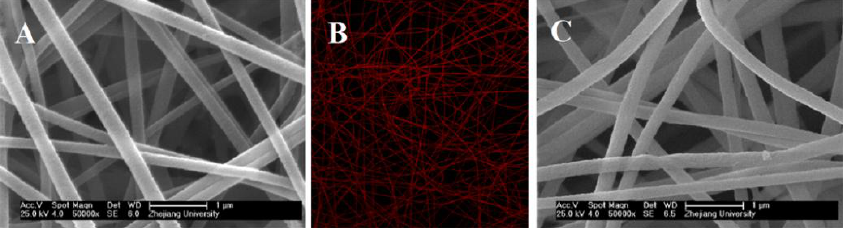
Figure 4. Absorption ( A ) and fluorescence emission ( B ) spectra of the ZPCPI nanofibrous membrane. A